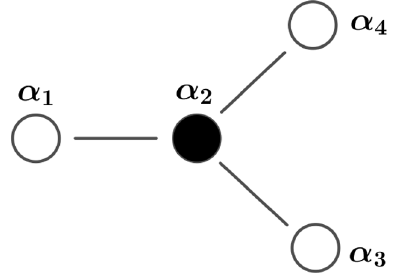
Figure 3 . D 4 Dynkin